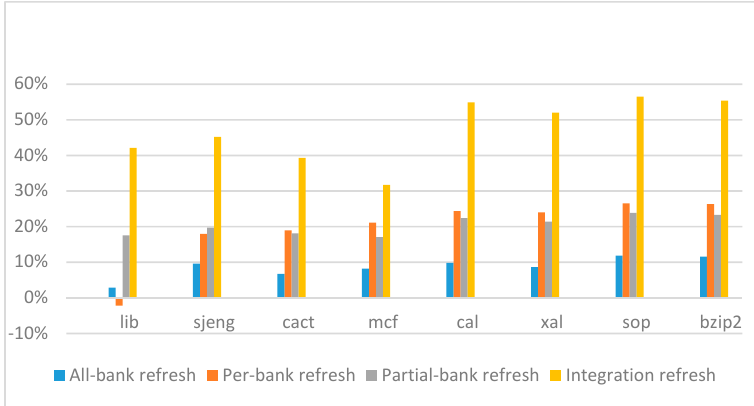
Figure 23. Energy reduction normalized to 1x granularity baseline (tRFC = 530 ns, weak row = 2%). Micromachines 2019 , 10 , x